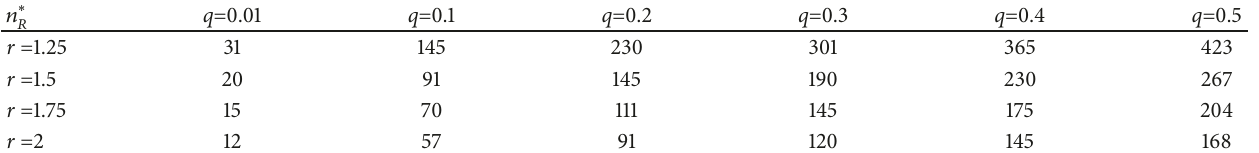
Table 4: The sensitivity of optimal reliable facility quantity to q (0.01, 0.5) and r (1.25,